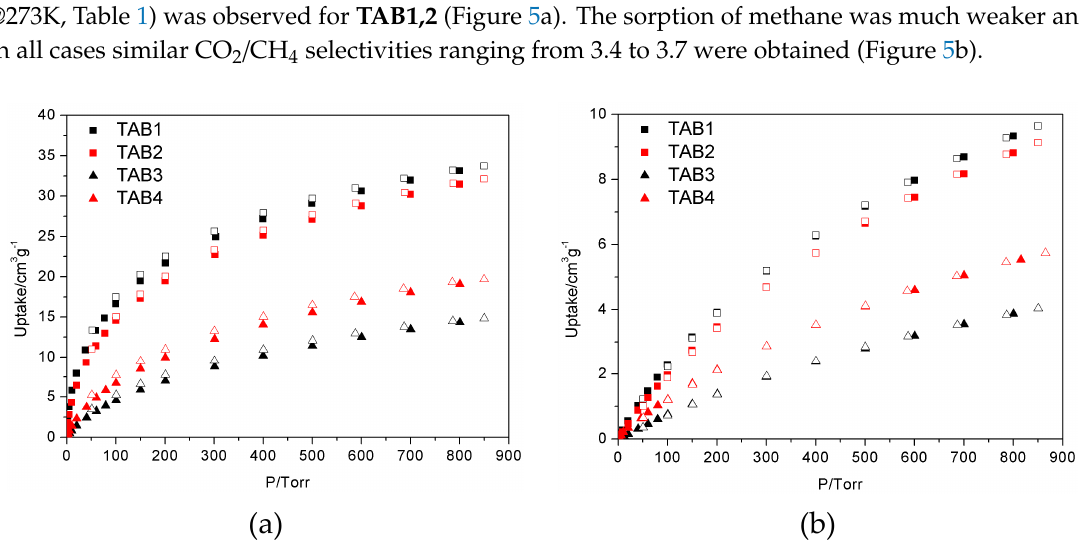
Figure 5. CO 2 ( a ) and CH 4 ( b ) sorption isotherms @273 K for materials TAB1–4. Table 1. Summary of surface areas S BET , gas uptakes (N 2 , H 2 ), and total pore volumes V p for TAB1–4 .